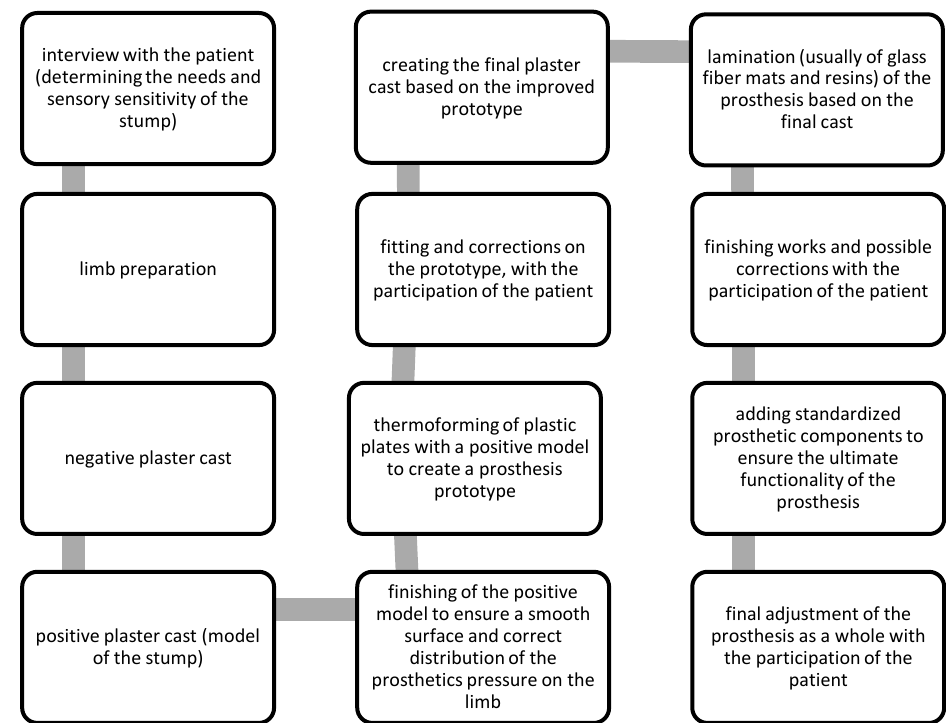
Figure 1. Flow graph — traditional manufacturing of prosthetic sockets, adapted from Ref. [13].